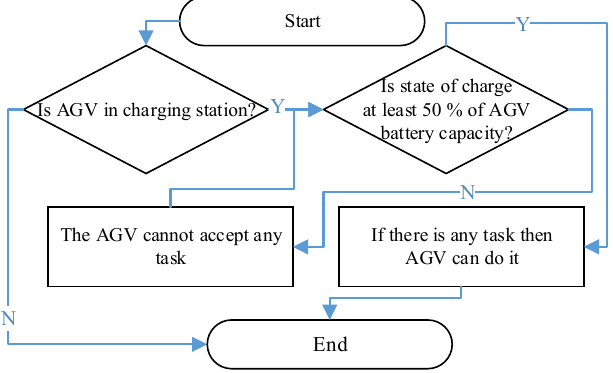
Figure 11. AGV charging logic, schematically.